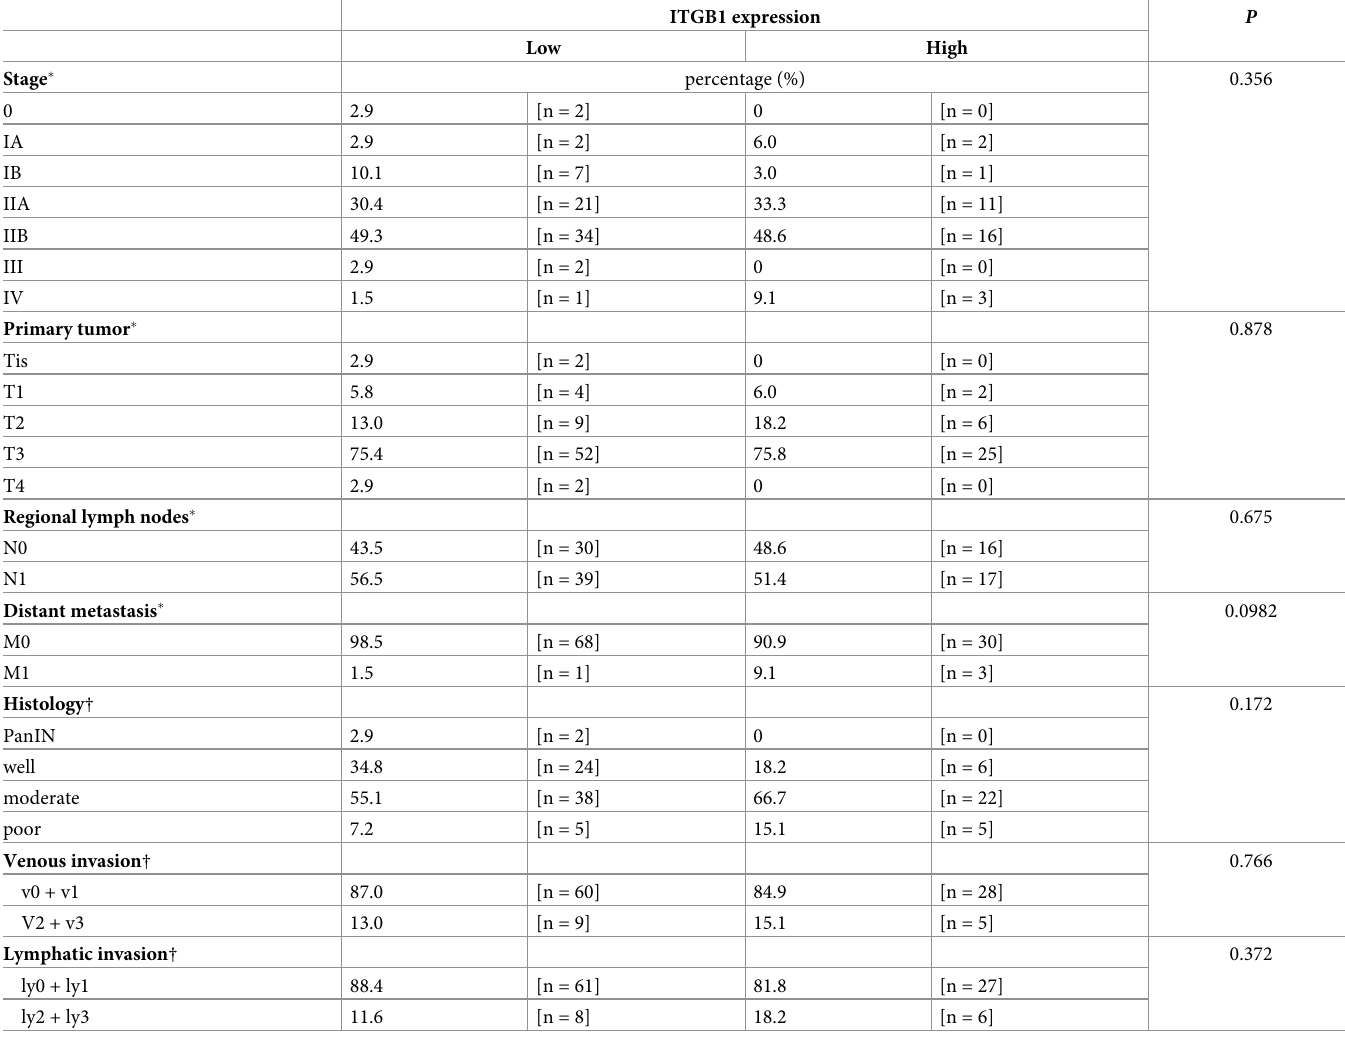
Table 2. Correlation between ITGB1 expression and clinicopathological